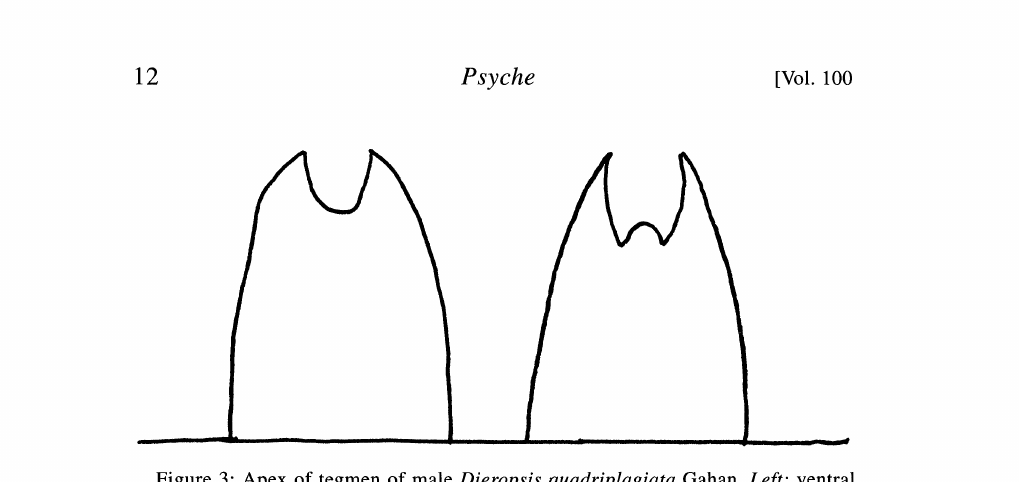
Figure 3: Apex of tegmen of male Dieropsis quadriplagiata Gahan. Left: ventral view; right: dorsal view.